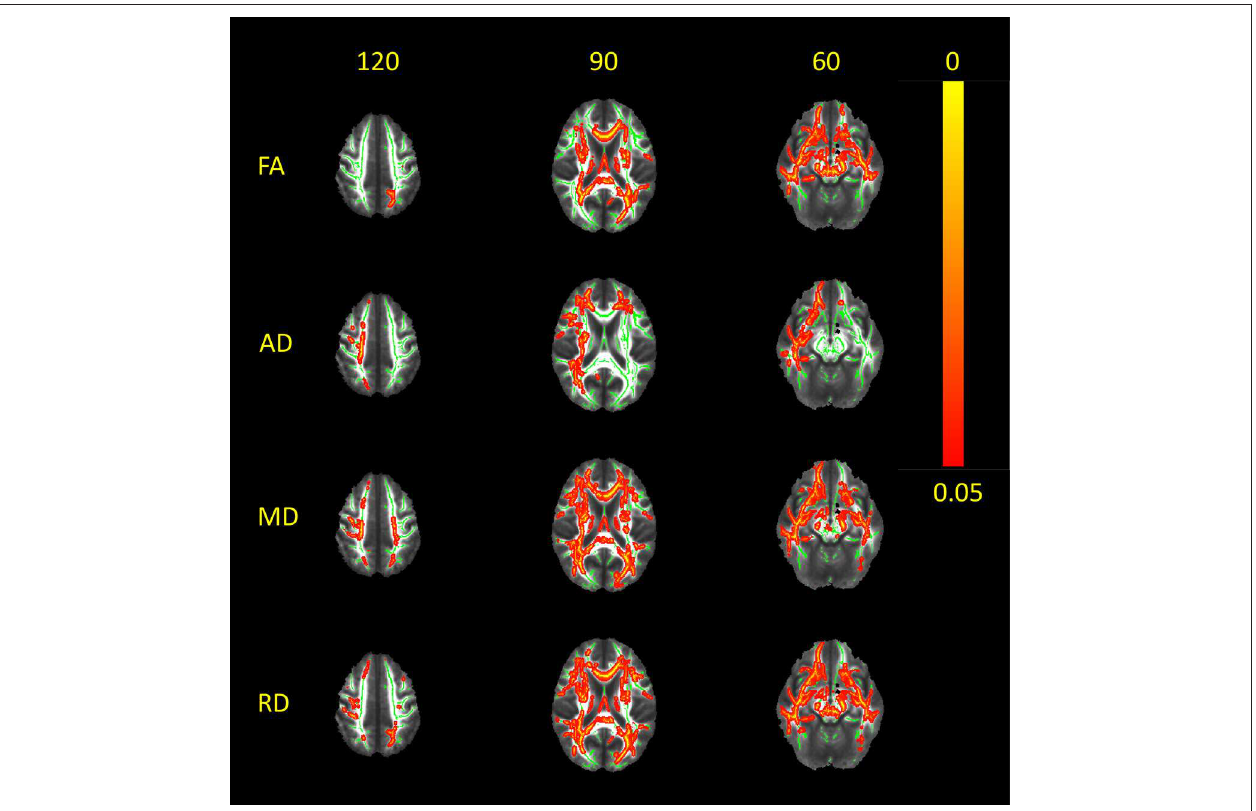
FIGURE 2 | White matter alterations in RTLE as compared to normal controls. Red-yellow clusters indicate statistically significant results in patients: widespread clusters of reduced FA as depicted in the center of fiber bundles, paralleled with increased MD, RD, and AD. It appears that patients with RTLE exhibit a large-scale pattern of WM alterations that extends beyond the temporal lobe. Significant clusters were thickened in order to obtain better visualization. Results are overlaid on the mean FA image; the WM skeleton thresholded at 0.2 is shown in green. Images are thresholded at p < 0.05, corrected for multiple comparisons. MD, mean diffusivity; AD, axial/longitudinal diffusivity; RD, radial/perpendicular